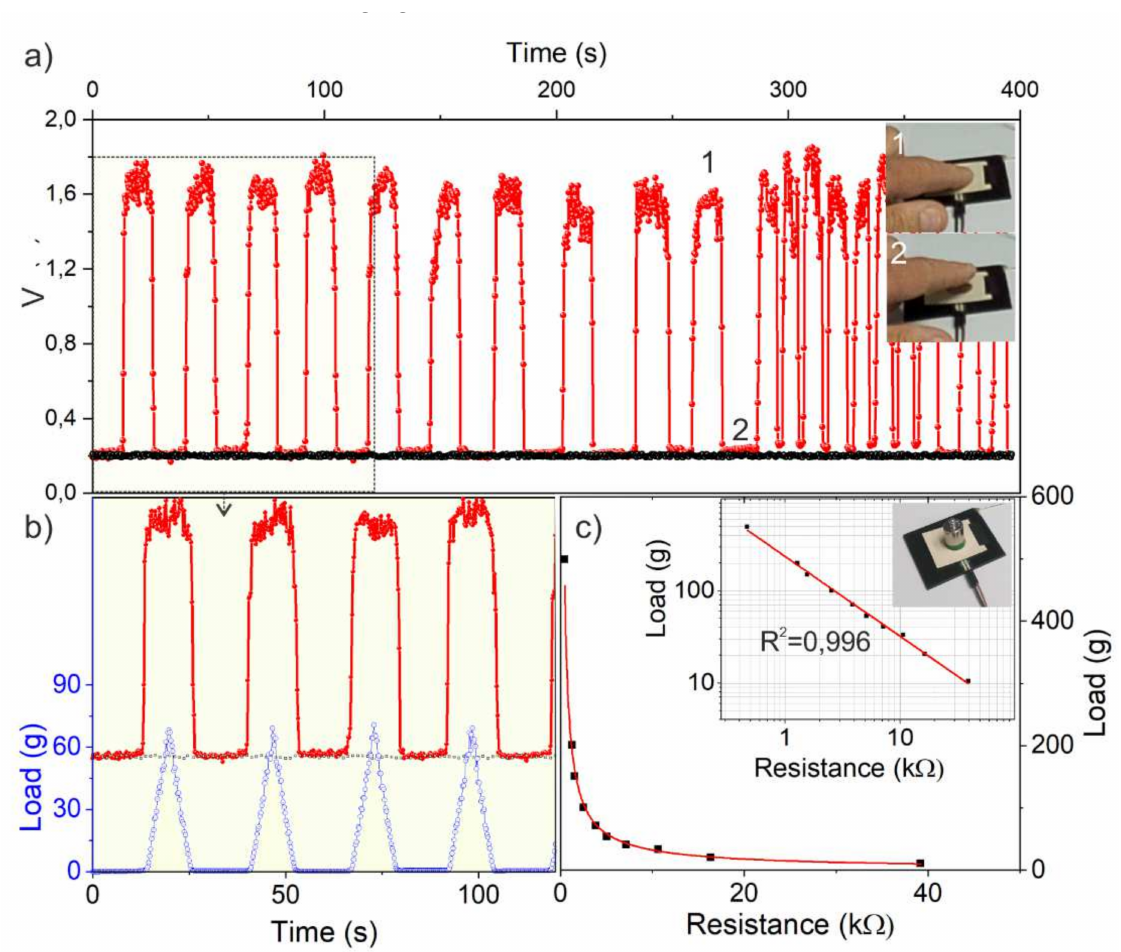
Figure 7. Output voltage between the two I/0 pins of the Arduino board connected with CB-filled PA66 specimens (50 × 50 × 2 mm in size) 9 and 17 wt. % (black and red data points, respectively). In ( a ), 1 and 2 refer to finger touching and not touching events illustrated in the insets, respectively; ( b ) a detail of the output voltage during the finger touching/not touching cycle (red curve: CB 17 wt. %, gray curve: CB 9 wt. %, which was measured together with the load applied by the finger; ( c ) electrical resistance calibration curve vs. the applied loads for the thin film sensor laying on the surface of the composite specimens. In the inset, the log–log plot of the weight calibration curve is